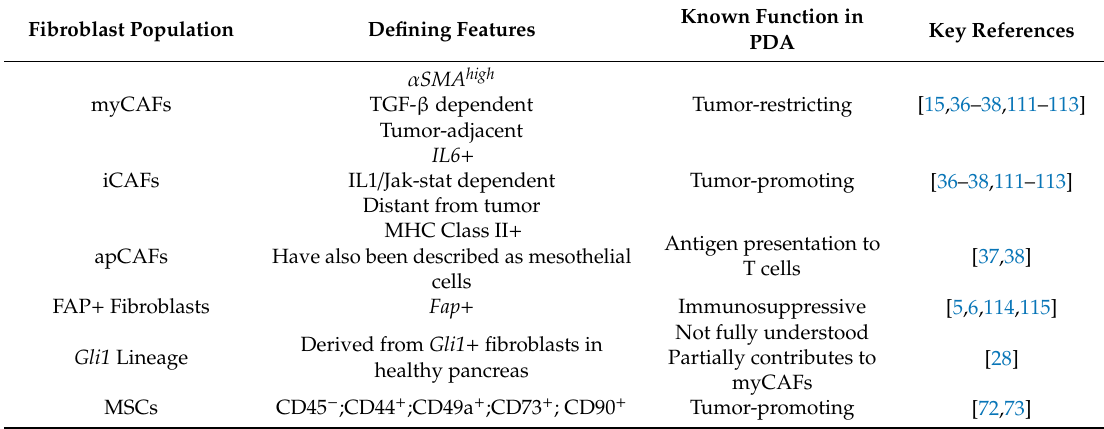
Table 1. Fibroblast Populations in Pancreatic